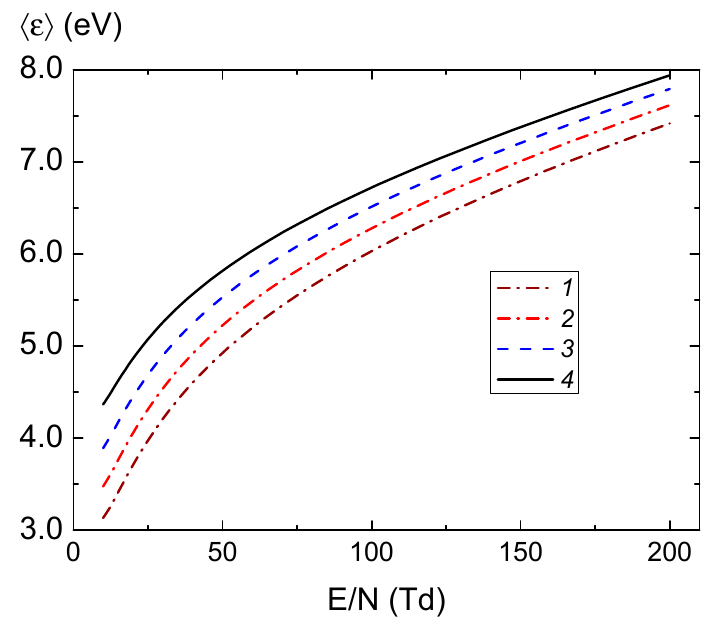
Figure 6. The dependence of the average electron energy on the specific intensity of the RF electric field with a frequency of 13.56 MHz in argon at pressure 1—3 Pa, 2—3.6 Pa, 3—4.5 Pa, 4—6 Pa.